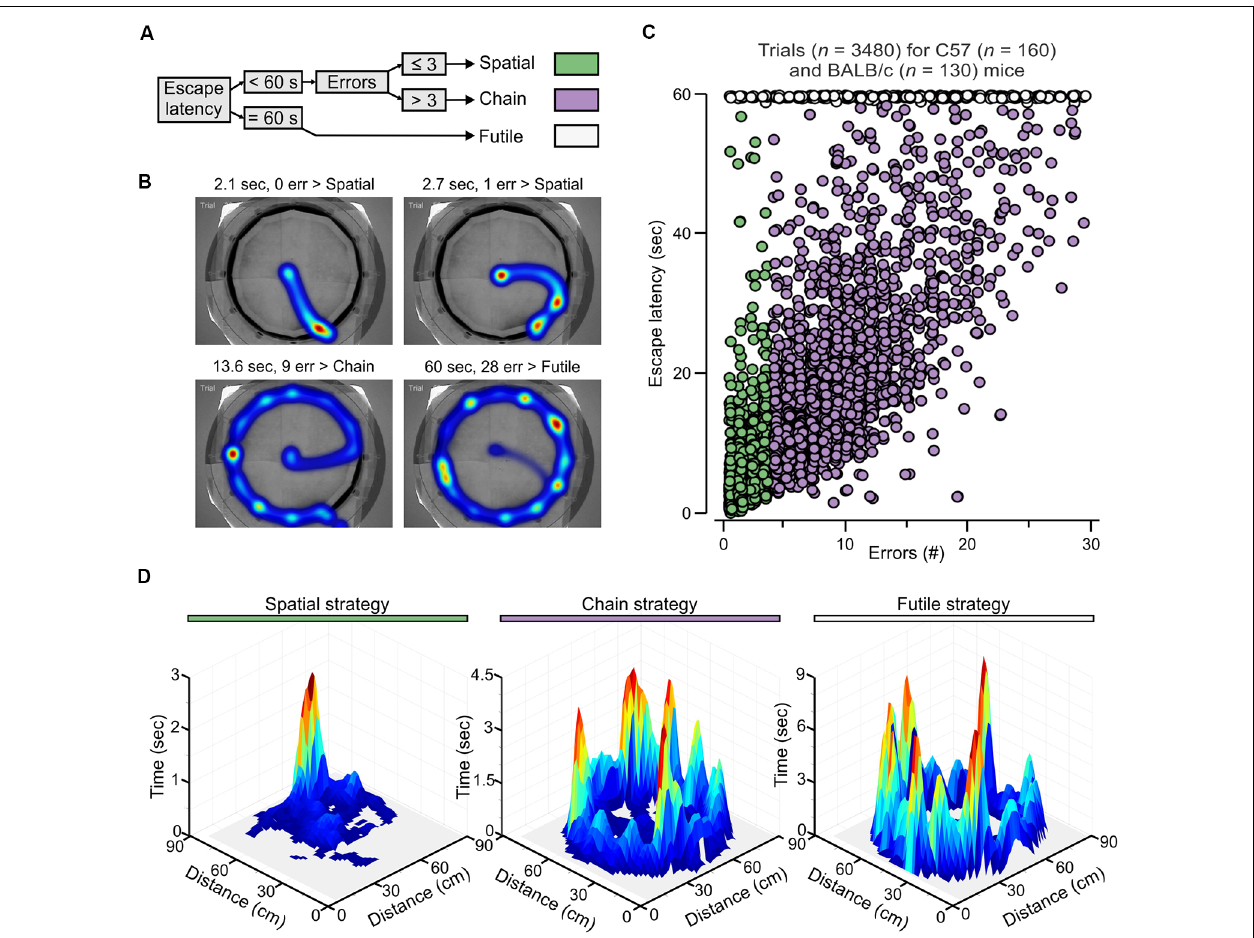
FIGURE 4 | Escape strategy analysis of the PPT. (A) Escape strategy classification algorithm based on escape latency and the number of errors. (B) Representative heatmaps for mice escaping to the true exit highlight the use of different strategies. Abbreviation: err, errors. (C) Graph of the number of errors vs. escape latency for individual trials of fully trained mice ( n = 290) showing segregation of strategies into three clusters (colors as in A ). (D) Three-dimensional surface plot showing the summation of the occupancy times taken from 40 randomly chosen trials, from different subjects with the same true exit (hole 11), for each escape strategy.